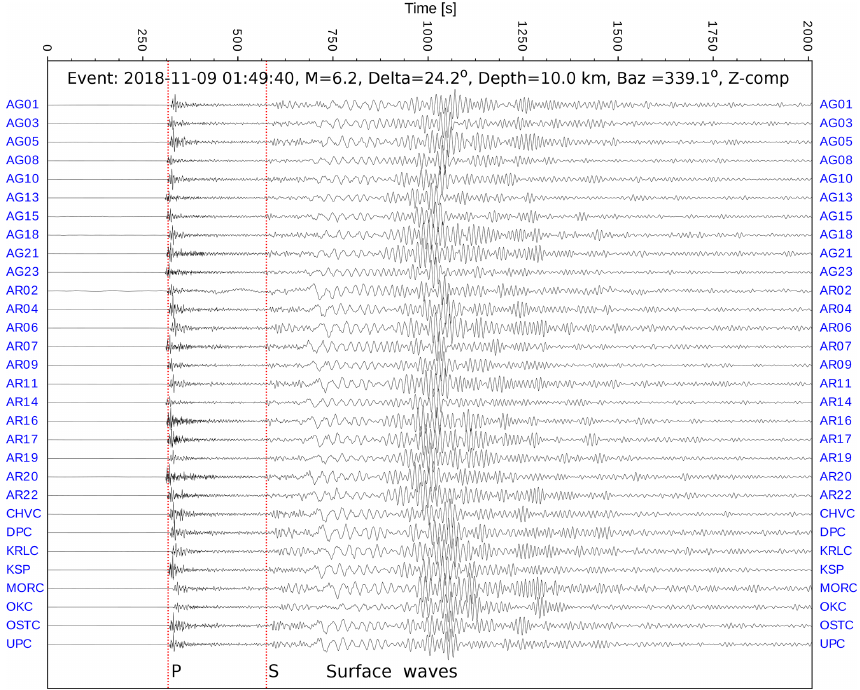
Figure 6. Example of vertical component of recorded waveforms for the M 6.2 teleseismic earthquake which occurred 9 November 2018 in Jan Mayen island region (lat: 71.6312, long: − 11 . 2431, depth: 10.0km after ISC). Red lines mark the theoretical onsets of P and S phases at the KSP station. All seismograms are low-pass filtered ( <